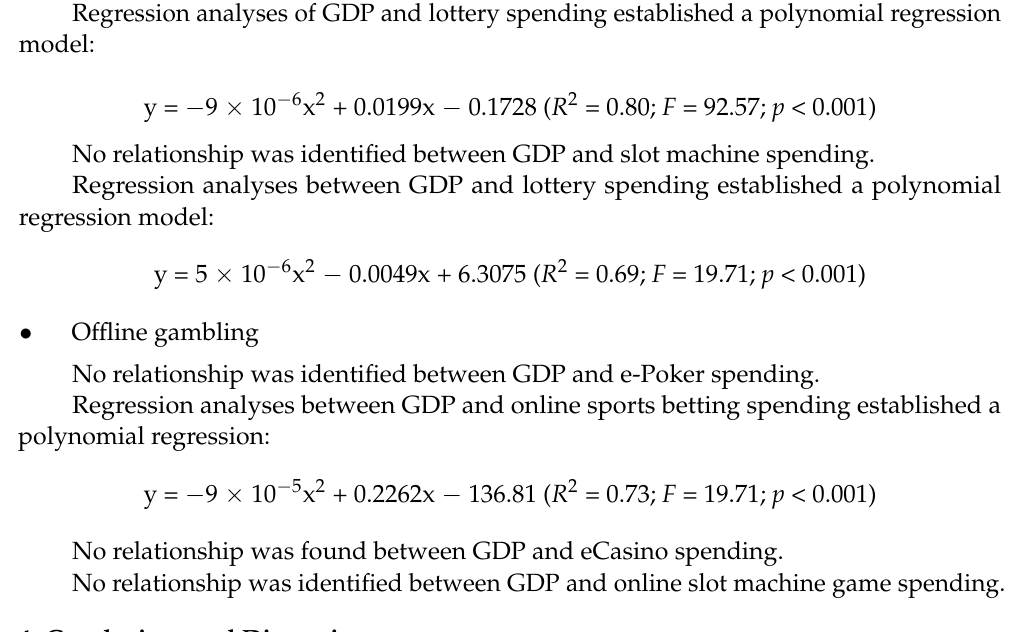
between GDP and online slot